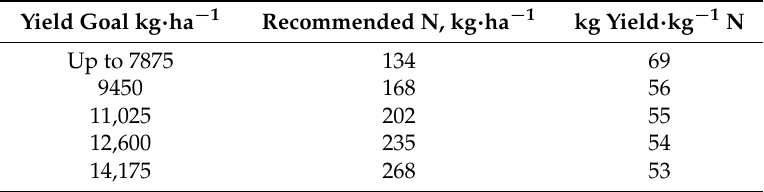
Table 2. Fertilizer recommendations (kg · ha − 1 ) for maize grown in Sandy Loams or Silt Loams, based on yield goal [37].